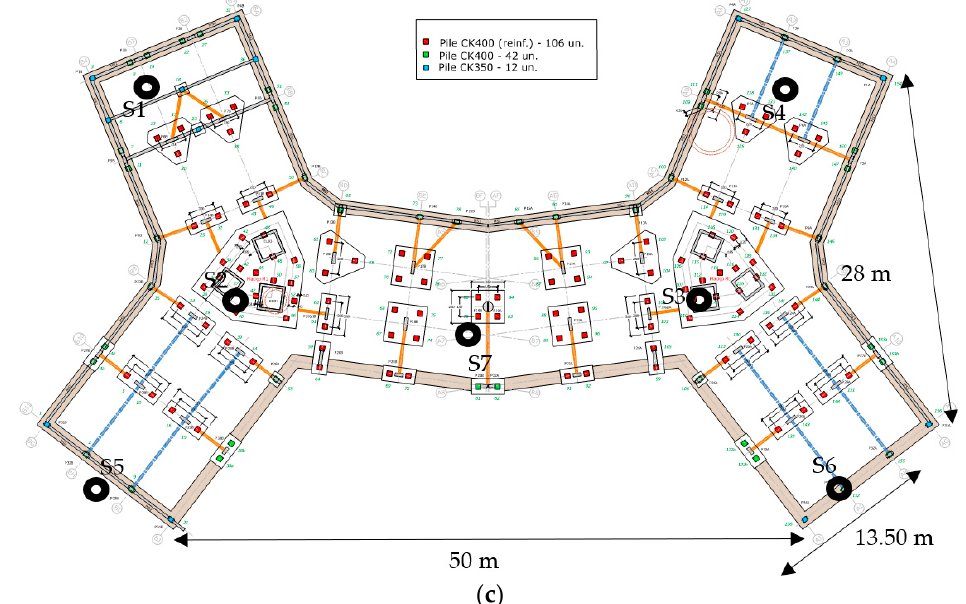
Figure 5. Experimental test site: ( a ) general view; ( b ) geological–geotechnical profile; ( c ) foundation plan and borehole’s location (S1–S7).